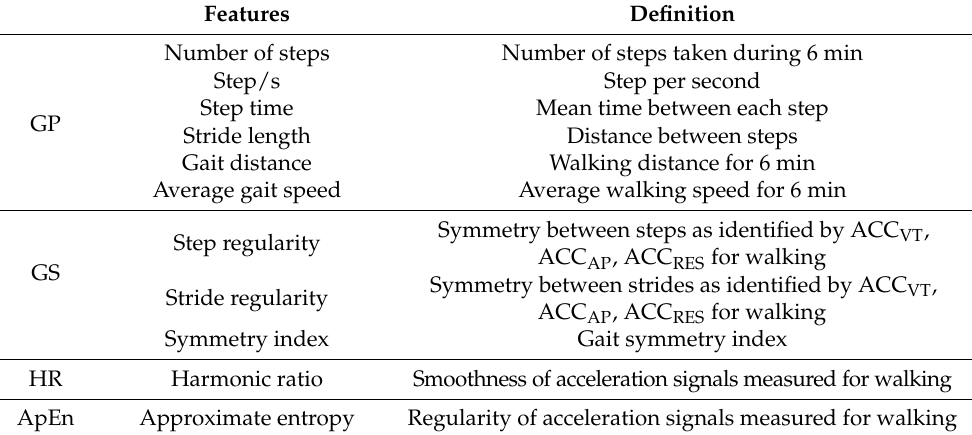
Table 2. Definitions of 6MWT